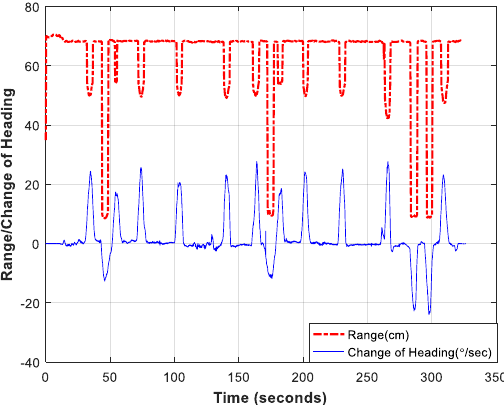
Figure 6. Ultrasonic sensors processed data versus the change of heading from GNSS/INS integration for the dominant right